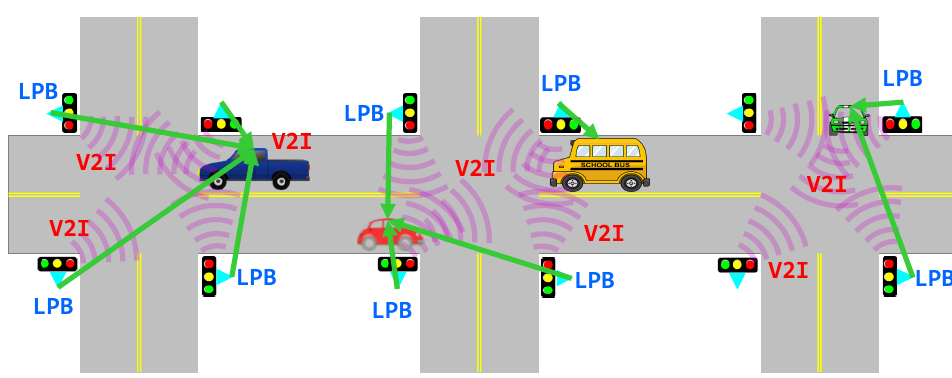
Figure 8. Block diagram of a multiple WPT environment using HILPB and V2I transmission.